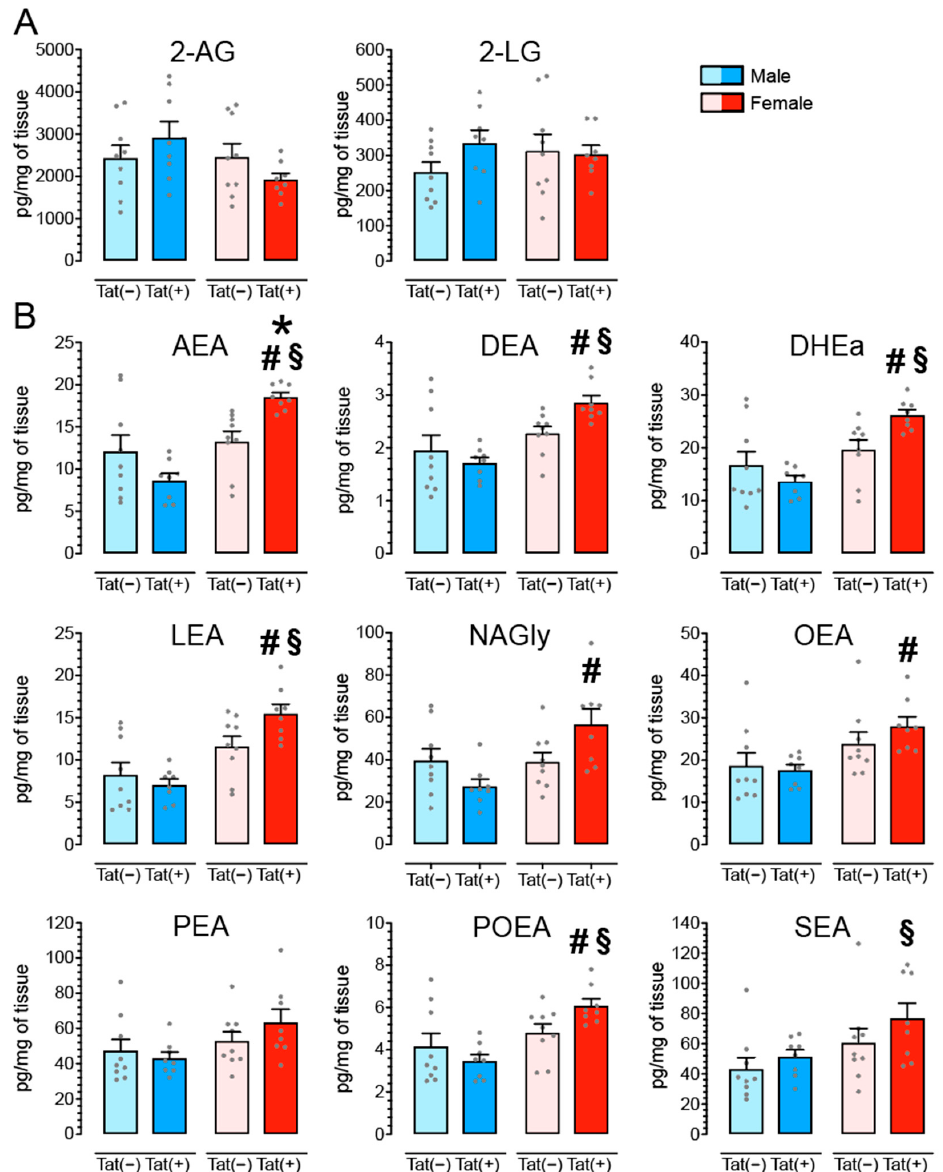
Figure 6. AEA and seven related non-eCB lipids are significantly upregulated in the PFC of female Tat(+) mice. Concentrations of AEA, 2-AG and other lipid molecules were assessed in the PFC of Tat transgenic mice using LC/MS/MS. Lipid concentrations were normalized to pg/mg of tissue. ( A ) No significant effects were noted for 2-AG or its related non-eCB lipid 2-LG. ( B ) For AEA and eight related non-eCB lipids, a significant sex and/or sex x genotype interaction was noted (see Table 1 for ANOVA results) with female Tat(+) mice demonstrating significant increased lipid concentrations in the PFC compared to one or more of the other three groups, except for PEA. Data of (non-)eCB concentration are expressed in pg/mg (mean ± SEM) separated by sex and genotype. Statistical significance was assessed by ANOVA followed by Bonferroni post hoc tests; * p < 0.05 vs. Tat( − ) female, # p < 0.05 vs. Tat(+) male, § p < 0.05 vs. Tat( − ) male. Sample size: n = 9, Tat( − ) mice per sex; n = 8, Tat(+) mice per sex. Please see Supplemental Table S2 for the actual concentration values (mean ± SEM).